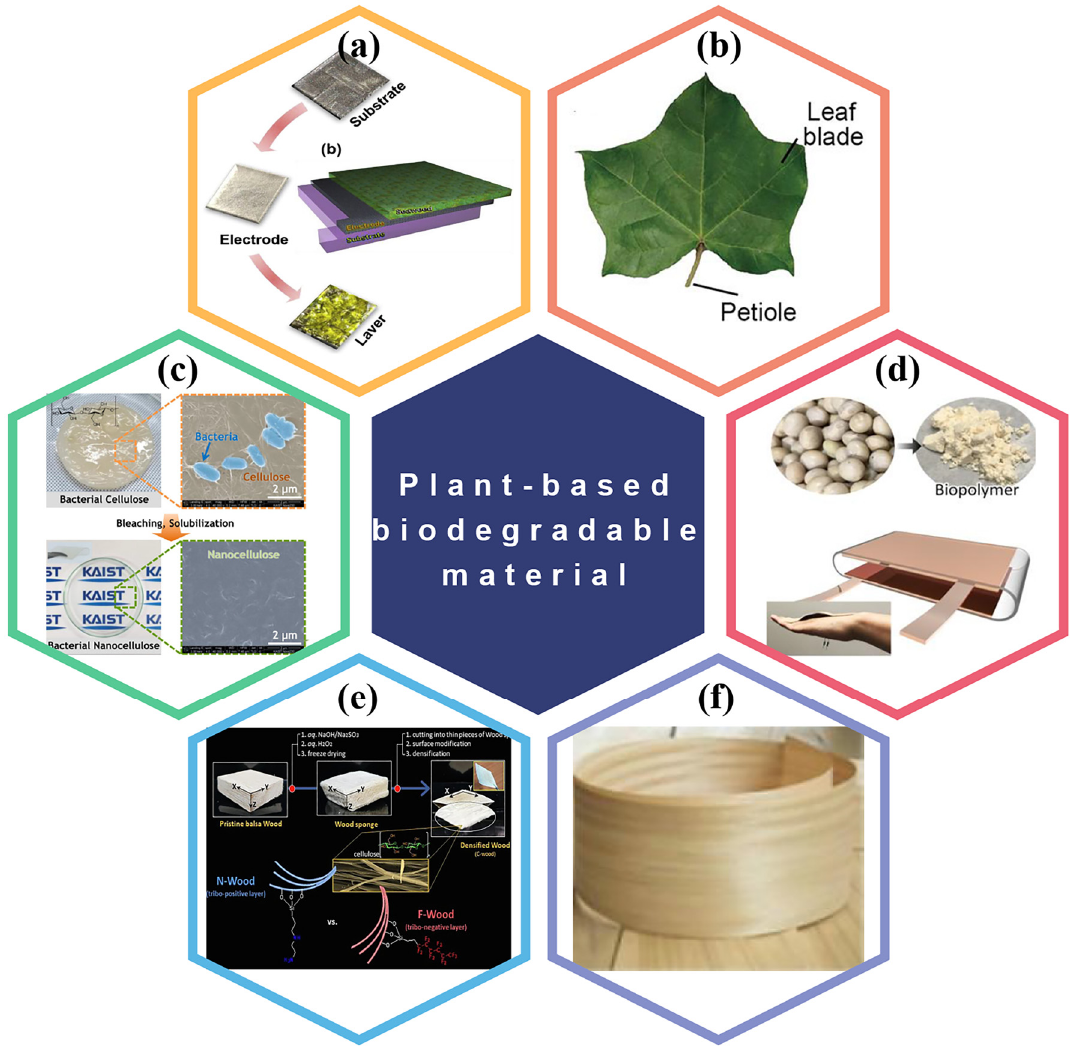
Figure 4. Plant-based biodegradable polymers used in BD-TENG. ( a ) All edible materials derived BD-TENG. Reproduced with permission [73], Copyright 2019, Elsevier Ltd. ( b ) Natural plant leaves used as triboelectric materials. Reproduced with permission [74], Copyright 2020, American Chemical Society. ( c ) Bacterial cellulose used as triboelectric material. Reproduced with permission [75], Copyright 2017, Elsevier Ltd. ( d ) Soybean protein and lignin used as triboelectric materials. Reproduced with permission [76], American Chemical Society. ( e , f ) Natural wood used as triboelectric material. Reproduced with permission [77], Copyright 2021, Elsevier B.V. Reproduced with permission [78], Copyright 2022, American Chemical Society.